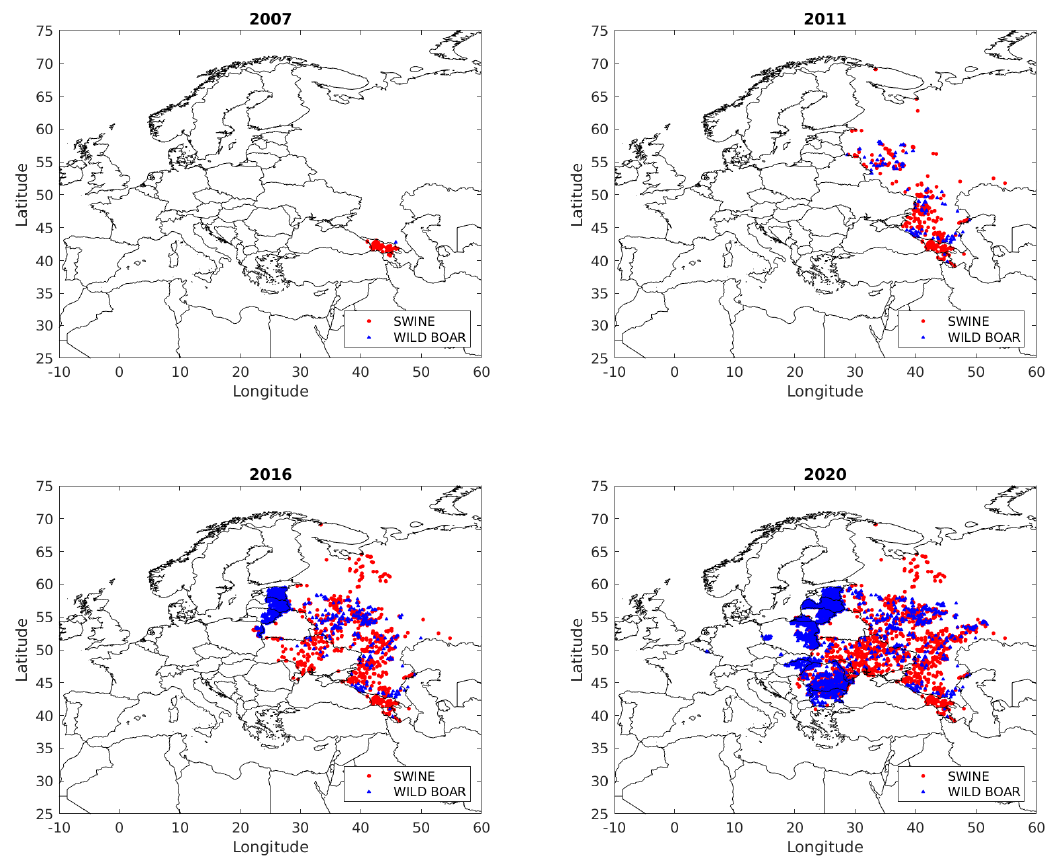
Figure 1. Evolution of ASF outbreaks in Europe since 2007 to 2020: Notified outbreaks of ASF in Europe (except Sardinia, Italy) summarized on years 2007, 2011, 2016 and 2020